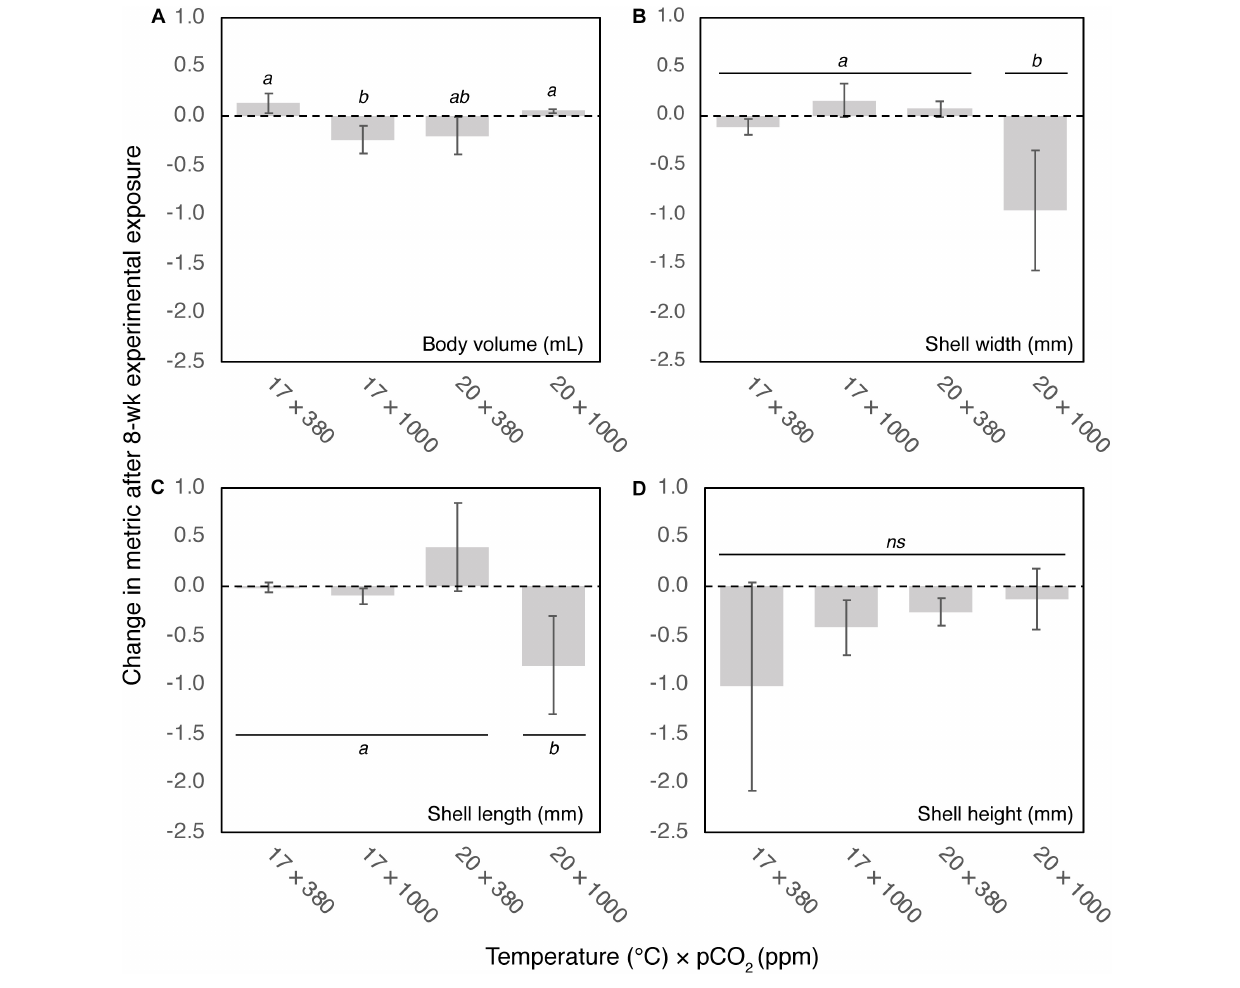
FIGURE 3 | Change in (A) body volume (mL), (B) shell width (mm), (C) length (mm), and (D) height (mm) after 8-week exposure to four climate scenarios. Error bars show standard error. Results of post hoc pairwise comparisons are shown, where shared letters indicate no significant difference between pairwise groups ( p > 0.05), and different letters indicate significant differences ( p < 0.05) between pairwise